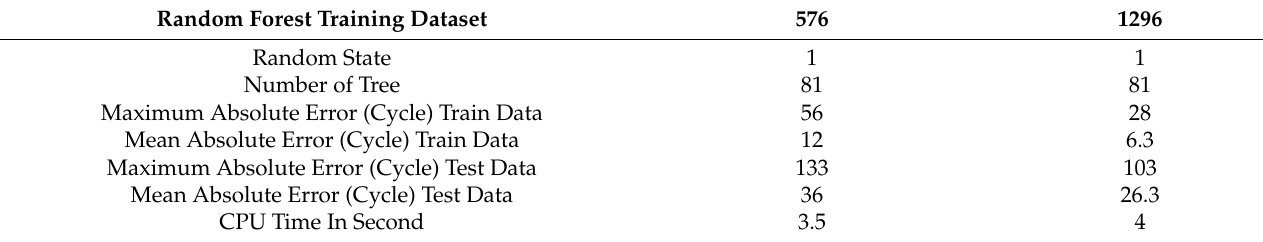
Table 23. RF result comparison with different